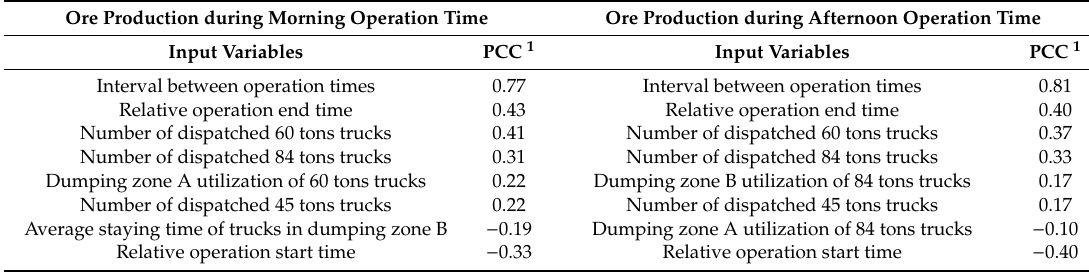
Table 3. Pearson correlation coe ffi cient values obtained between di ff erent input variables and ore production during the morning and afternoon operation